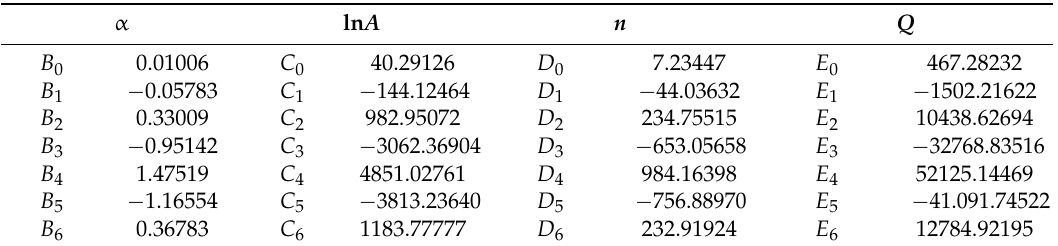
Table 1. Polynomial fitting results of superalloy nimonic 80A.